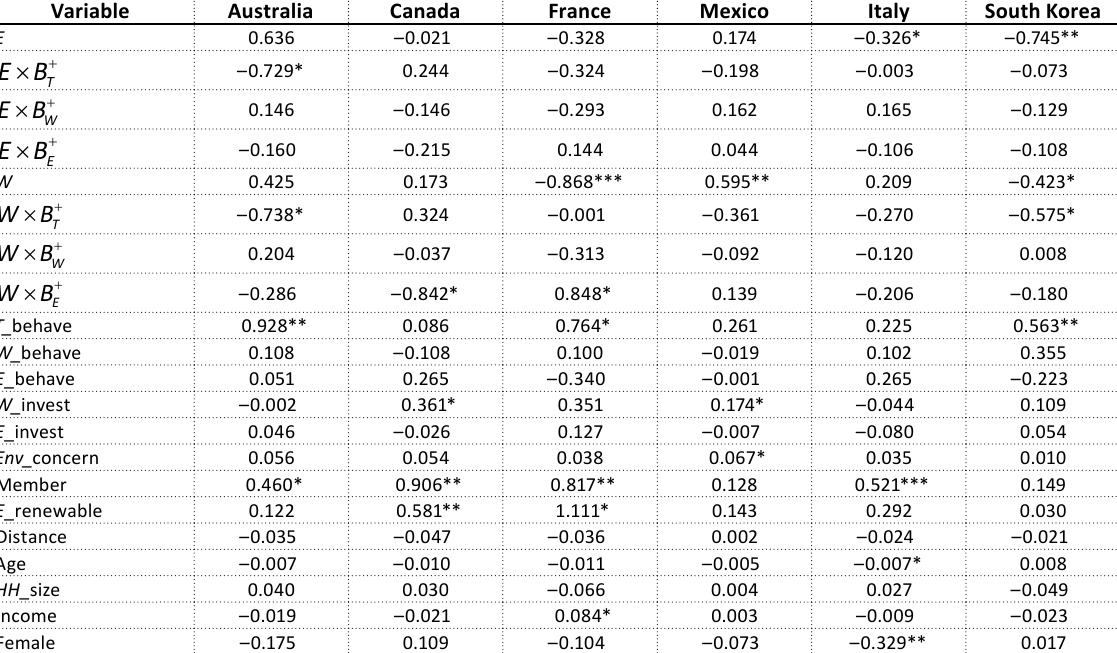
Table B6. Countrvwise parameter estimates of ordered probit with random